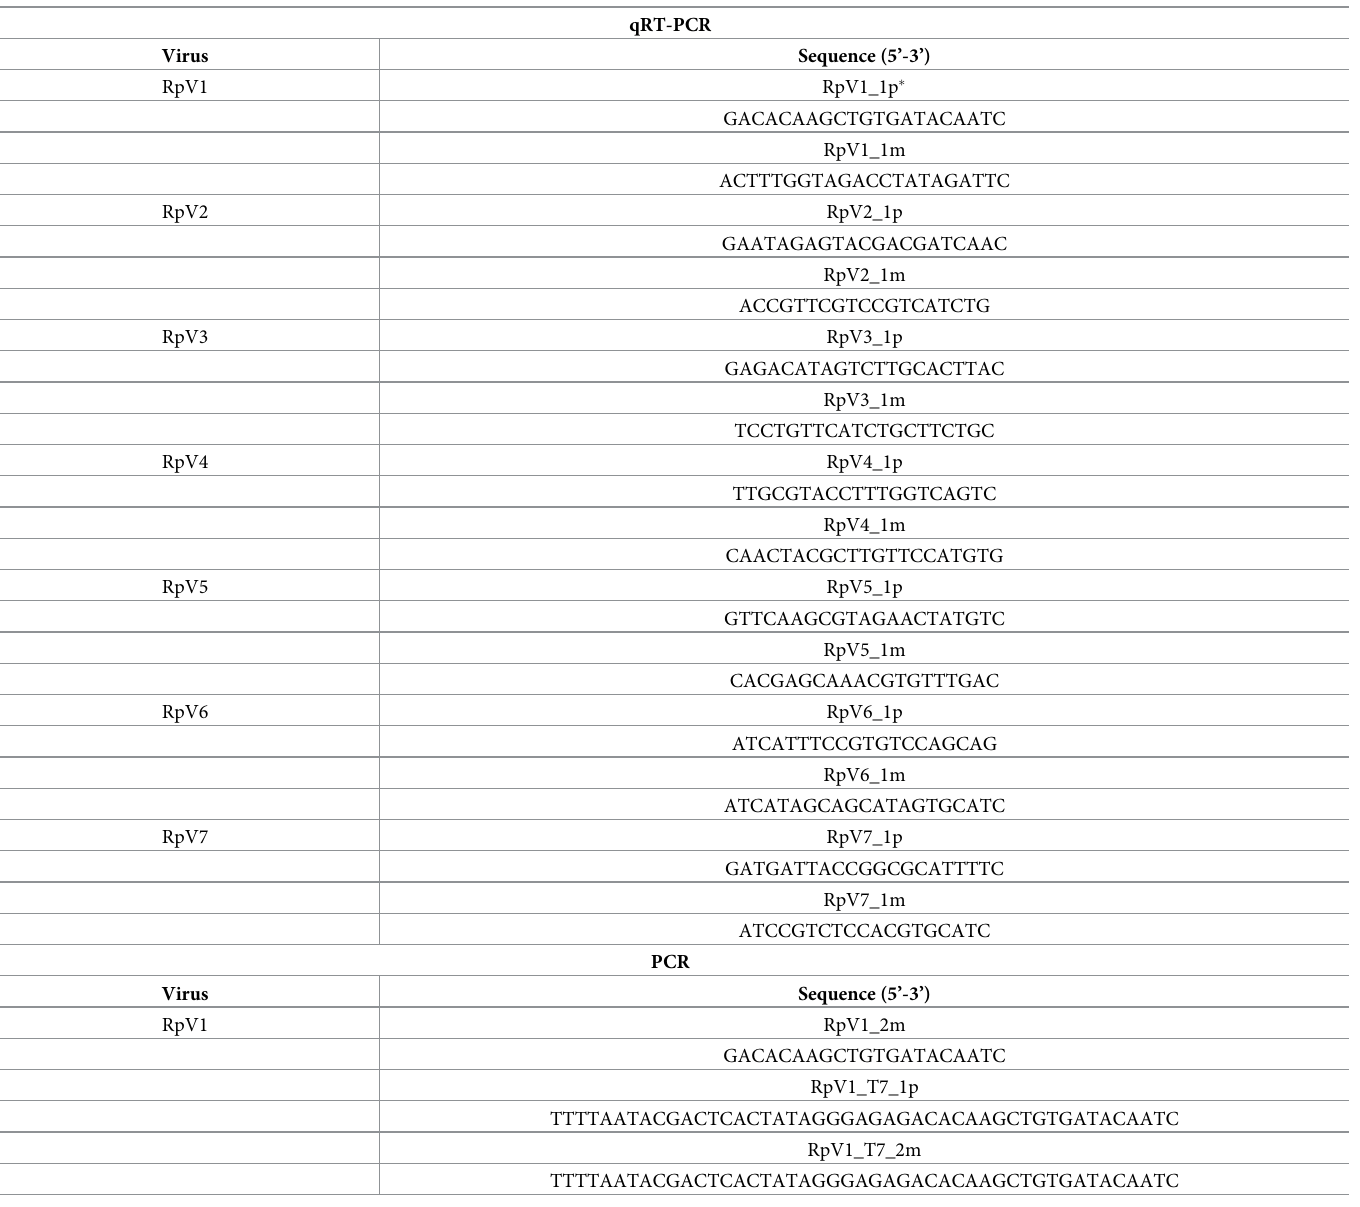
Table 1. Oligonucleotides used in this